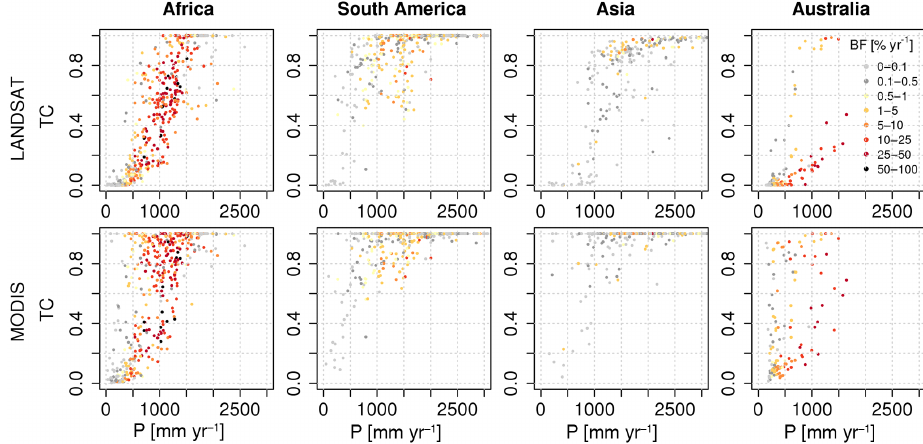
Figure A3. Tree cover (TC) versus precipitation ( P ) with colour-coded burned fraction (BF). Tree cover was here remapped from 0.05 ◦ resolution to 2 ◦ using the maximum value of the higher resolution instead of the